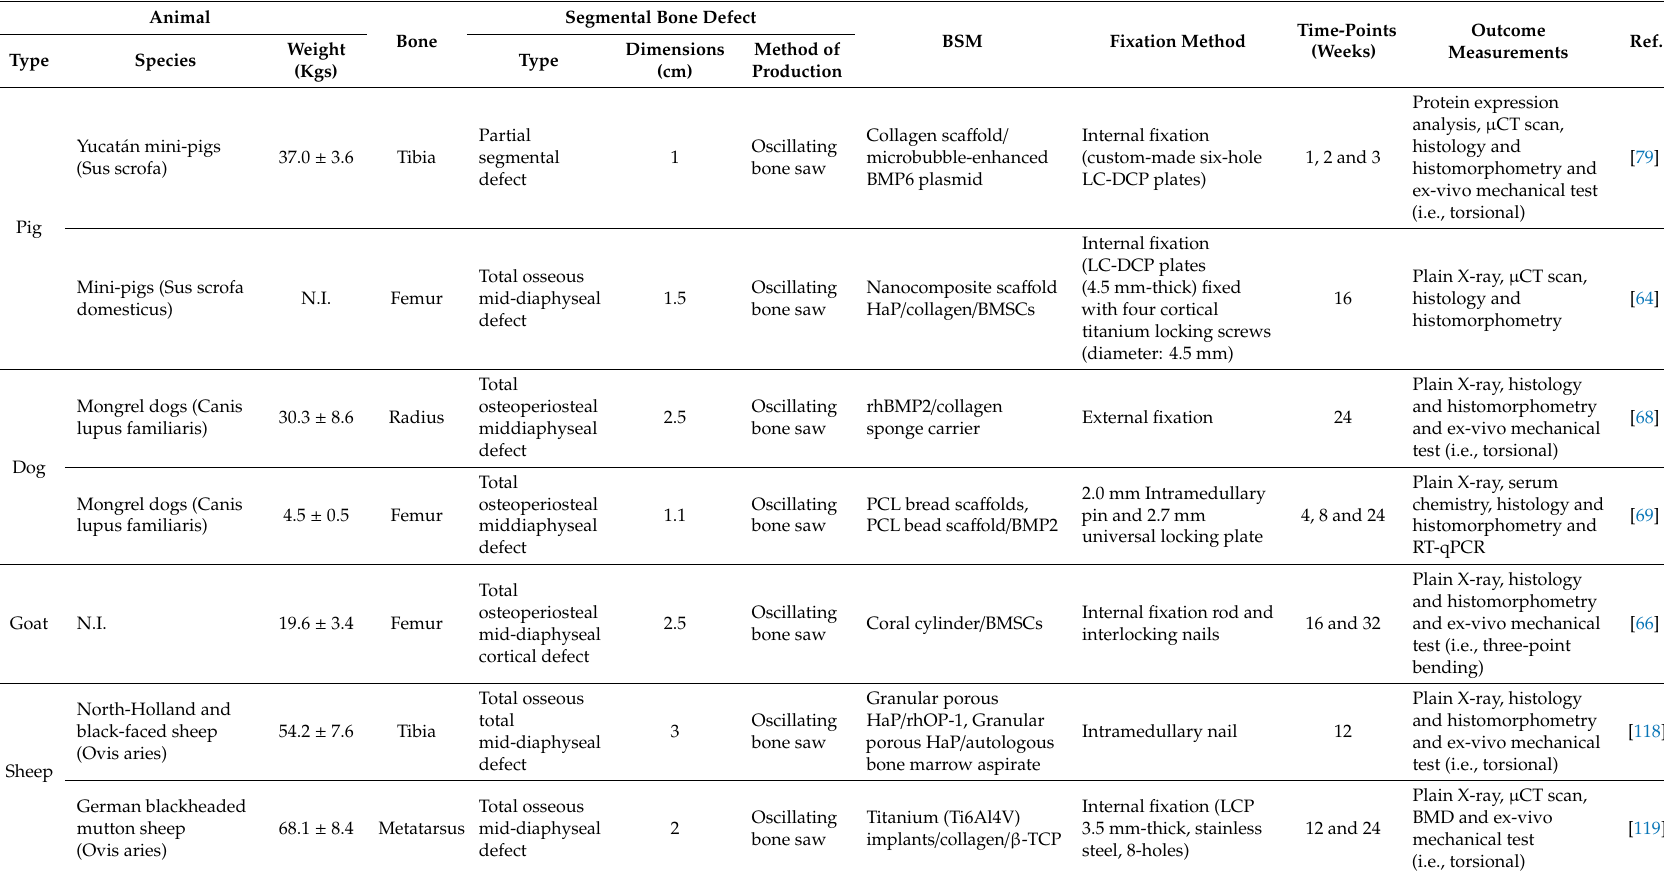
Table 2. Selection of preclinical segmental bone defect studies for development of biological